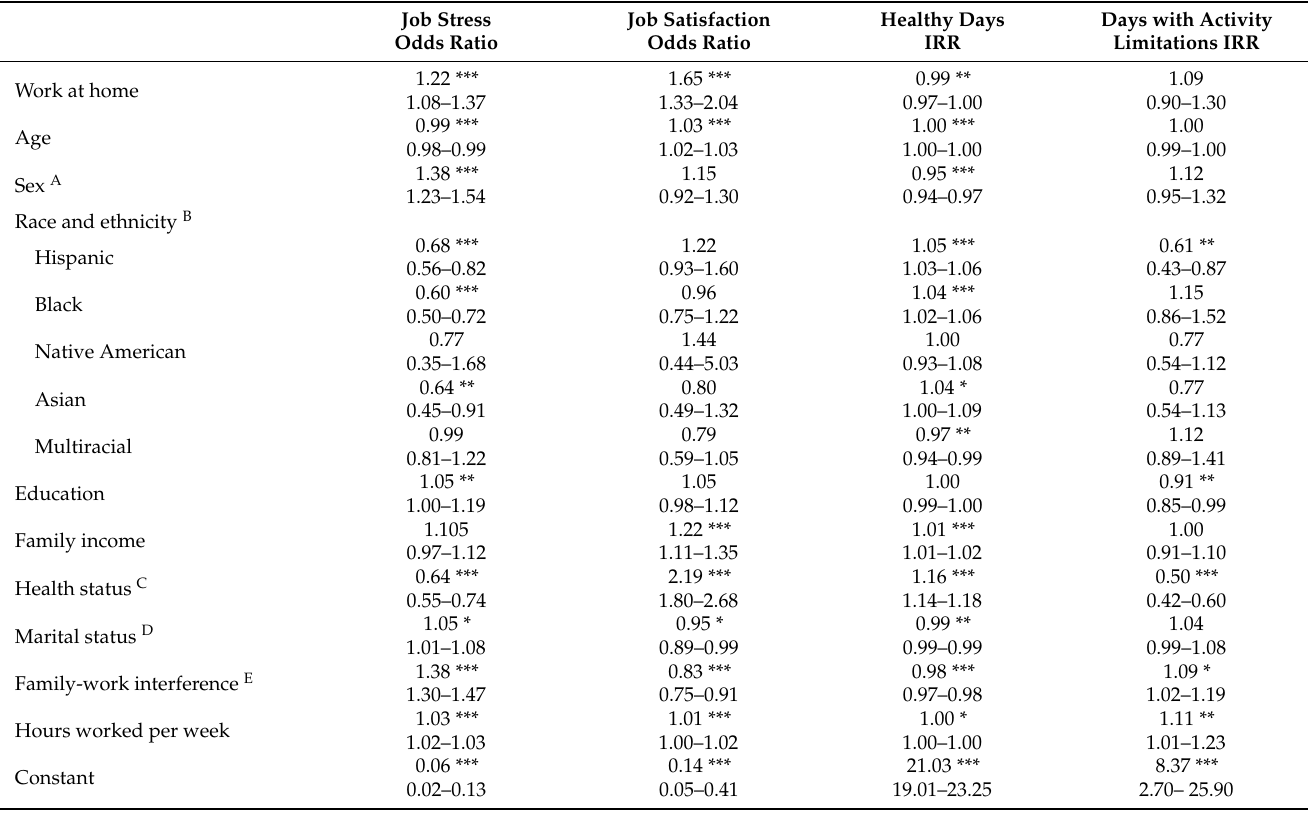
Table 5. Ability to work at home and well-being, pooled GSS-QWL